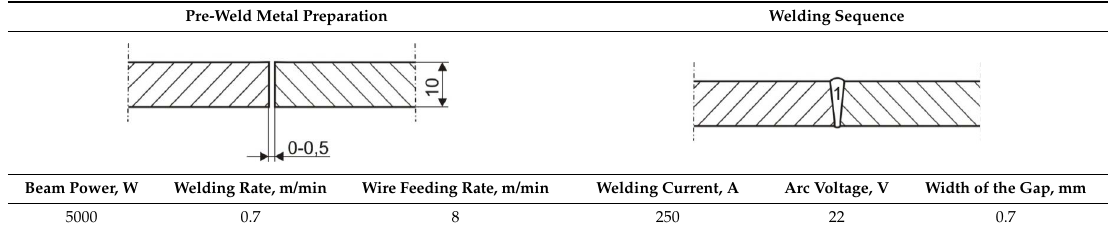
Figure 5. Hybrid welding station (laser beam-Metal Active Gas (MAG)). Table 3. Parameters of the hybrid welding of 10-mm-thick steel S700MC.